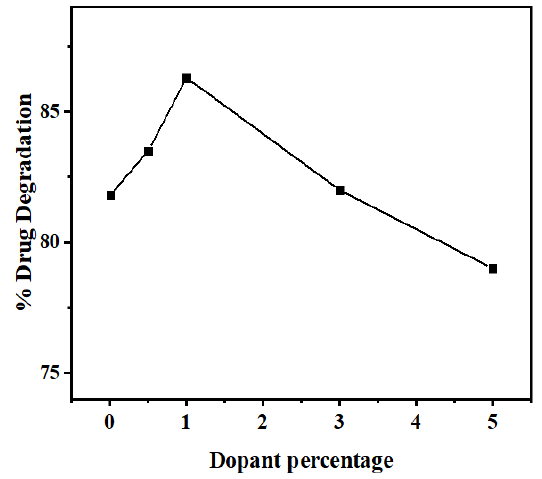
Figure 16. E ff ect of Mn 2 + dopant percentage on the photocatalytic degradation of drug NOFX under Figure 16. Effect of Mn 2+ dopant percentage on the photocatalytic degradation of drug NOFX under optimal conditions (25 mL of drug NOFX, pH 10, 60 min irradiation, 60 mgs optimal conditions (25 mL of drug NOFX, pH 10, 60 min irradiation, 60 mgs QDs).